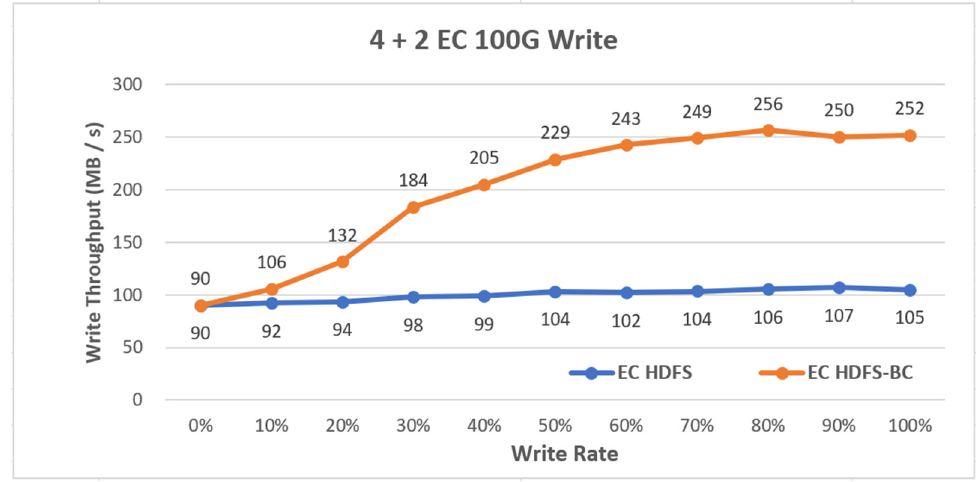
Figure 20. Comparison between EC-based HDFS and improvement-applied performances.